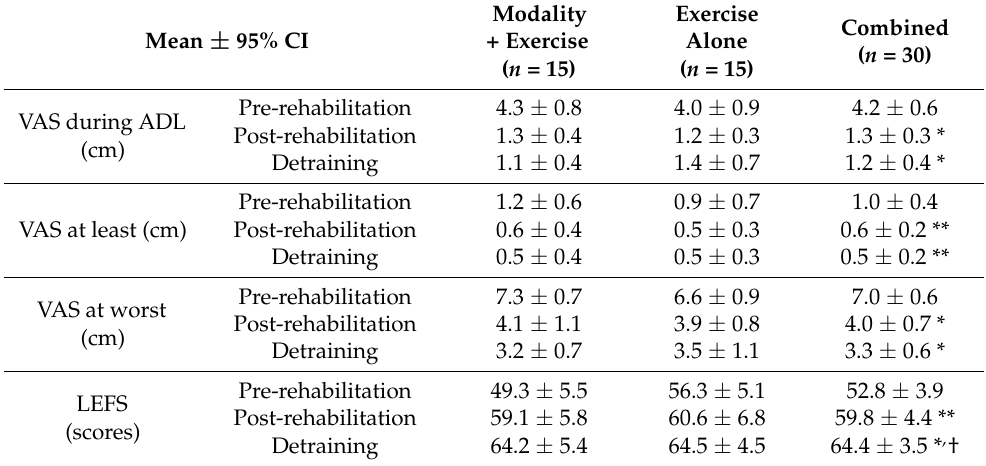
Table 4. Changes in self-reported